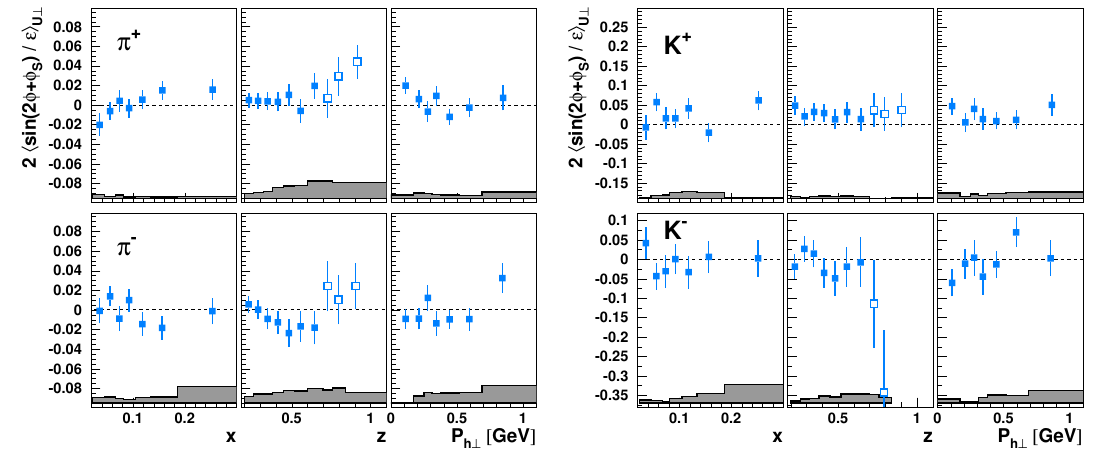
Figure 33 . The 2 h sin(2 φ + φ S ) /(cid:15) i h amplitudes for charged mesons (left: pions; right: kaons) U ⊥ presented either in bins of x , z , or P h ⊥ . Data at large values of z , marked by open points in the z projection, are not included in the other projections. Systematic uncertainties are given as bands, not including the additional scale uncertainty of 7.3% due to the precision of the target-polarization